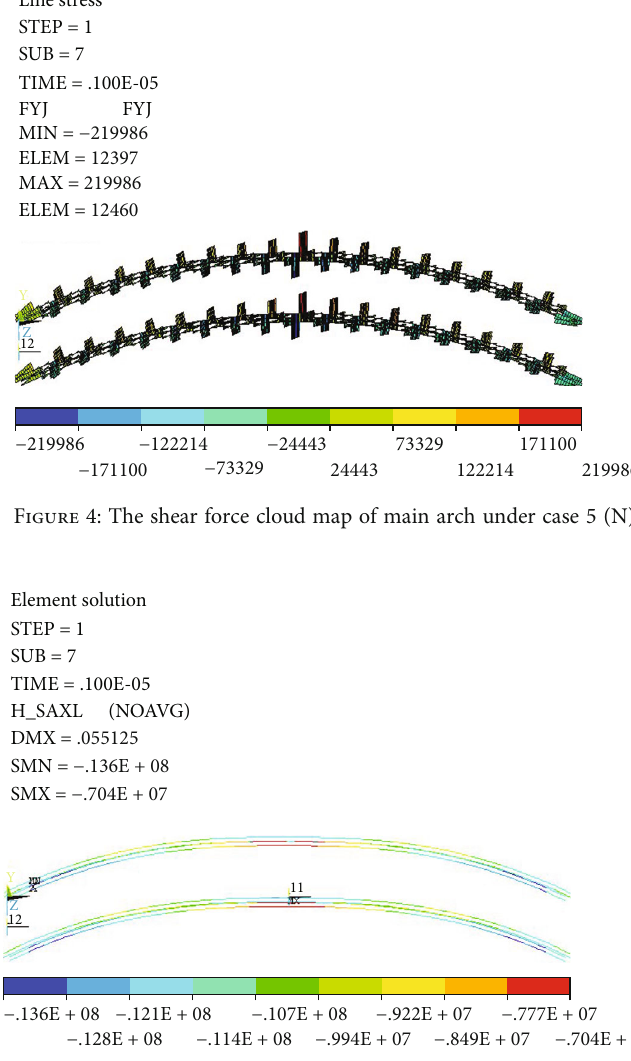
Figure 5: The axial stress cloud map of main arch under case 5